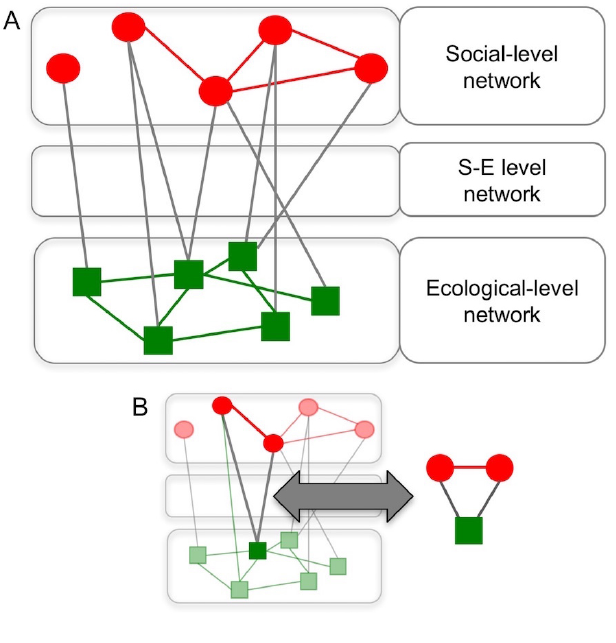
Fig. 2. A social–ecological system (SES) represented as a social–ecological network (A), and how key network configurations act as building blocks that support larger social– ecological structures (B). The multilevel structure captures the dependencies that exist within the system, i.e., how social and ecological system elements relate to and depend on each other, and the constraints and opportunities social actors face in taking actions within the system